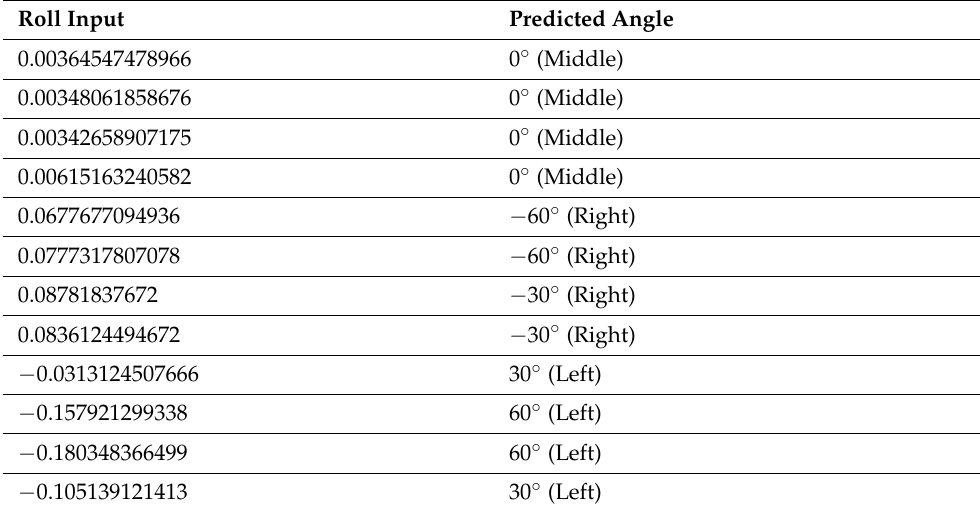
Table 1. KNN model test data and results.